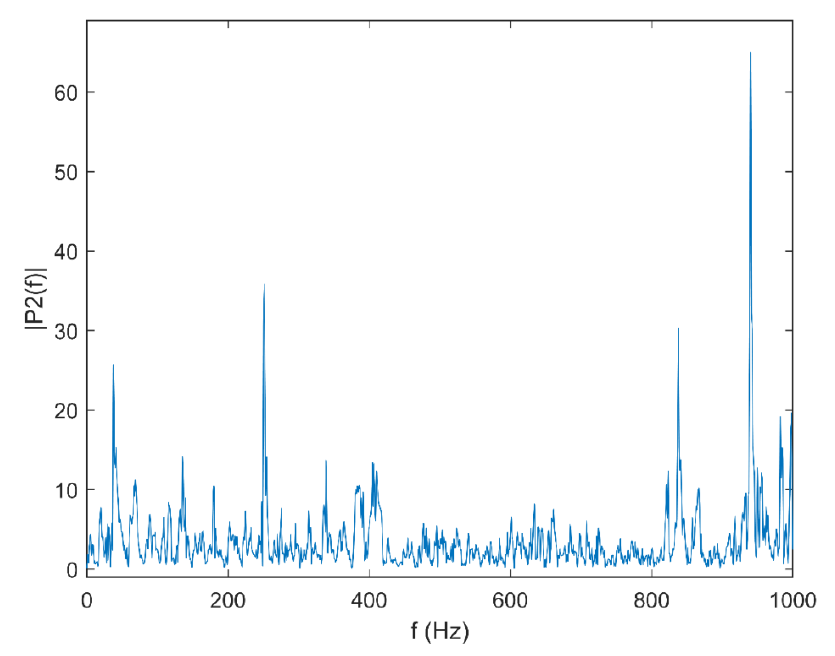
Figure 3. Fast Fourier Transform of acceleration at rail seat position under the crossing nose.